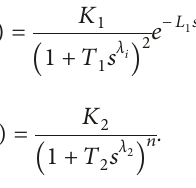
1/ α }, where x � 5, 10, 15, 20, 25, and 30, and curve fitting for f 100 ‒ x ) i , q i } of the rational function f 3 ( α ) for the different sets of symmetrical points.